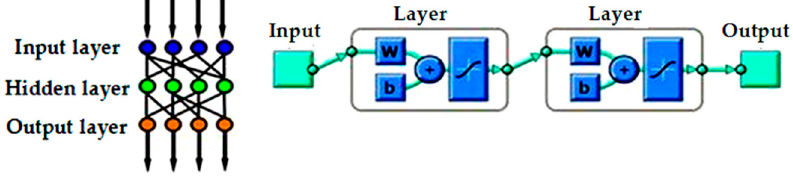
Figure 10. Feed Forward Network Structure.